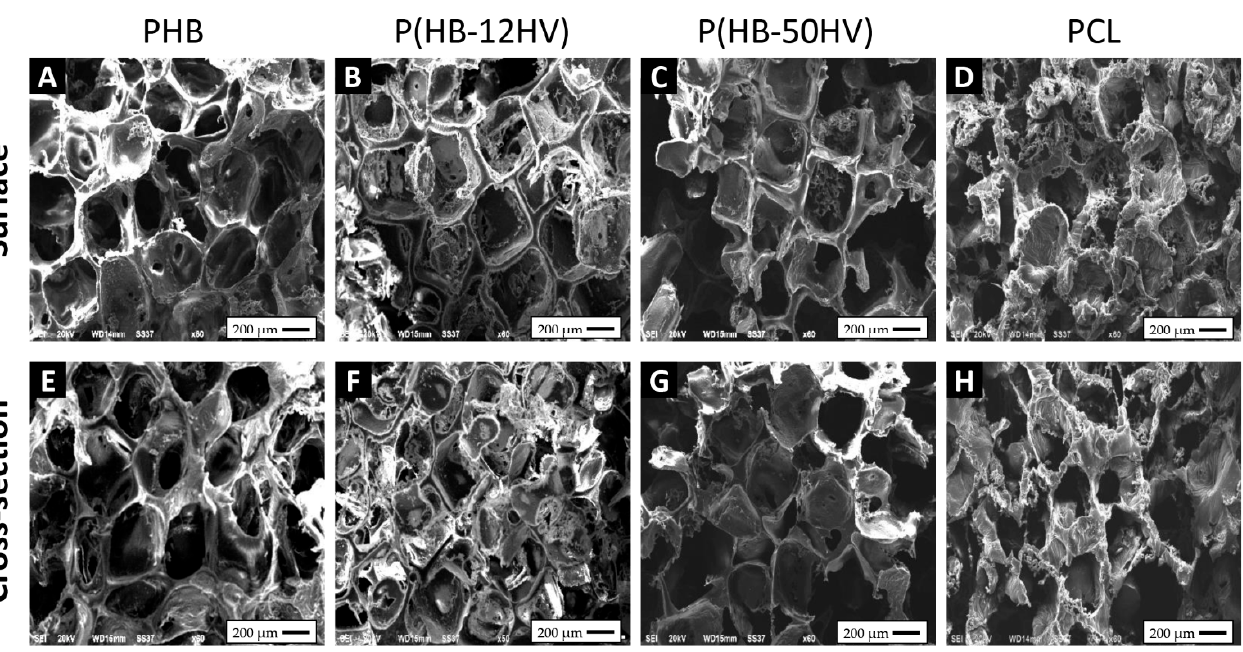
Figure 2. Photographic images of 3D porous scaffolds via the particulate salt leaching technique.